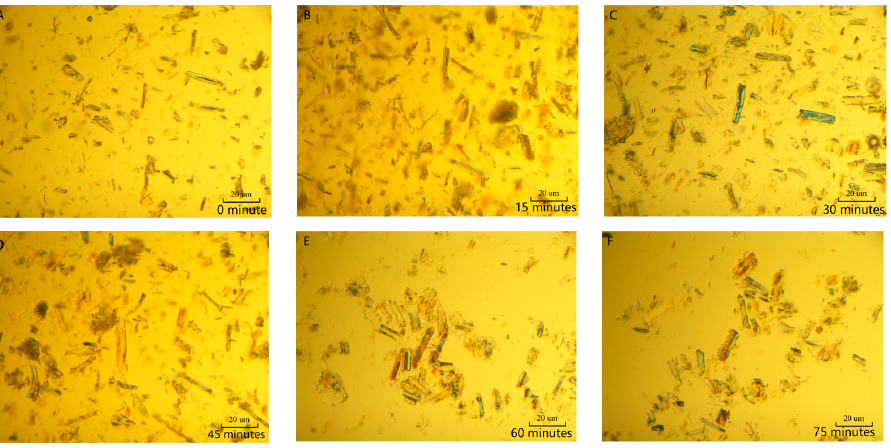
Figure 2. E ff ect of swelling time on sizes of MCC in [AMIm][Cl]. (( A ) 0 min; ( B ) 15 min; ( C ) 30 min; ( D ) 45 min; ( E ) 60 min; ( F ) 75